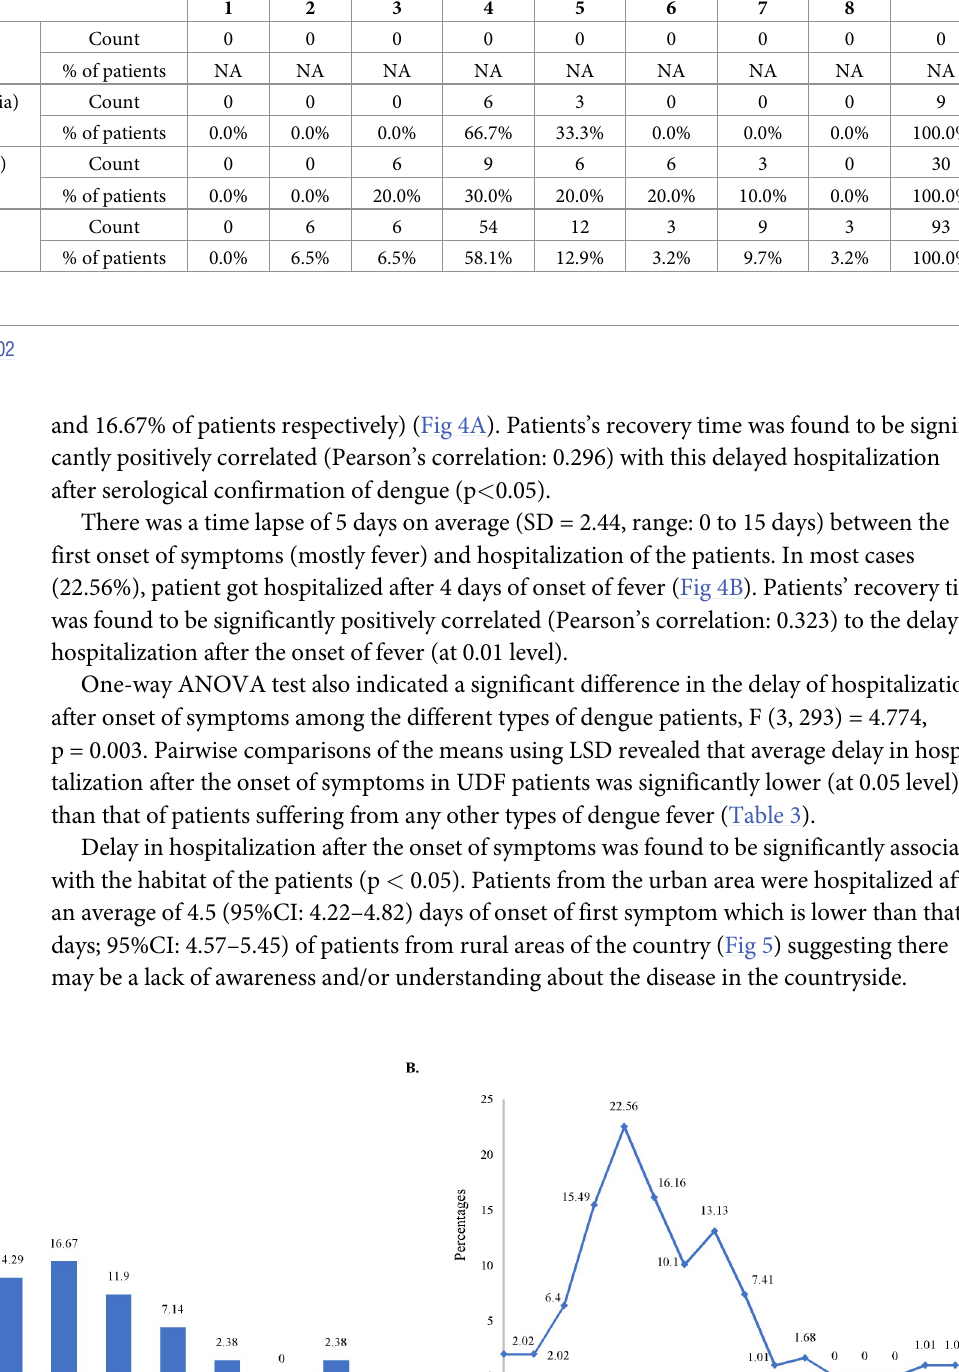
Table 2. Distribution of cases according to the recovery time and platelet count on the day of admission (data available for 132 patients). Platelet count at admission